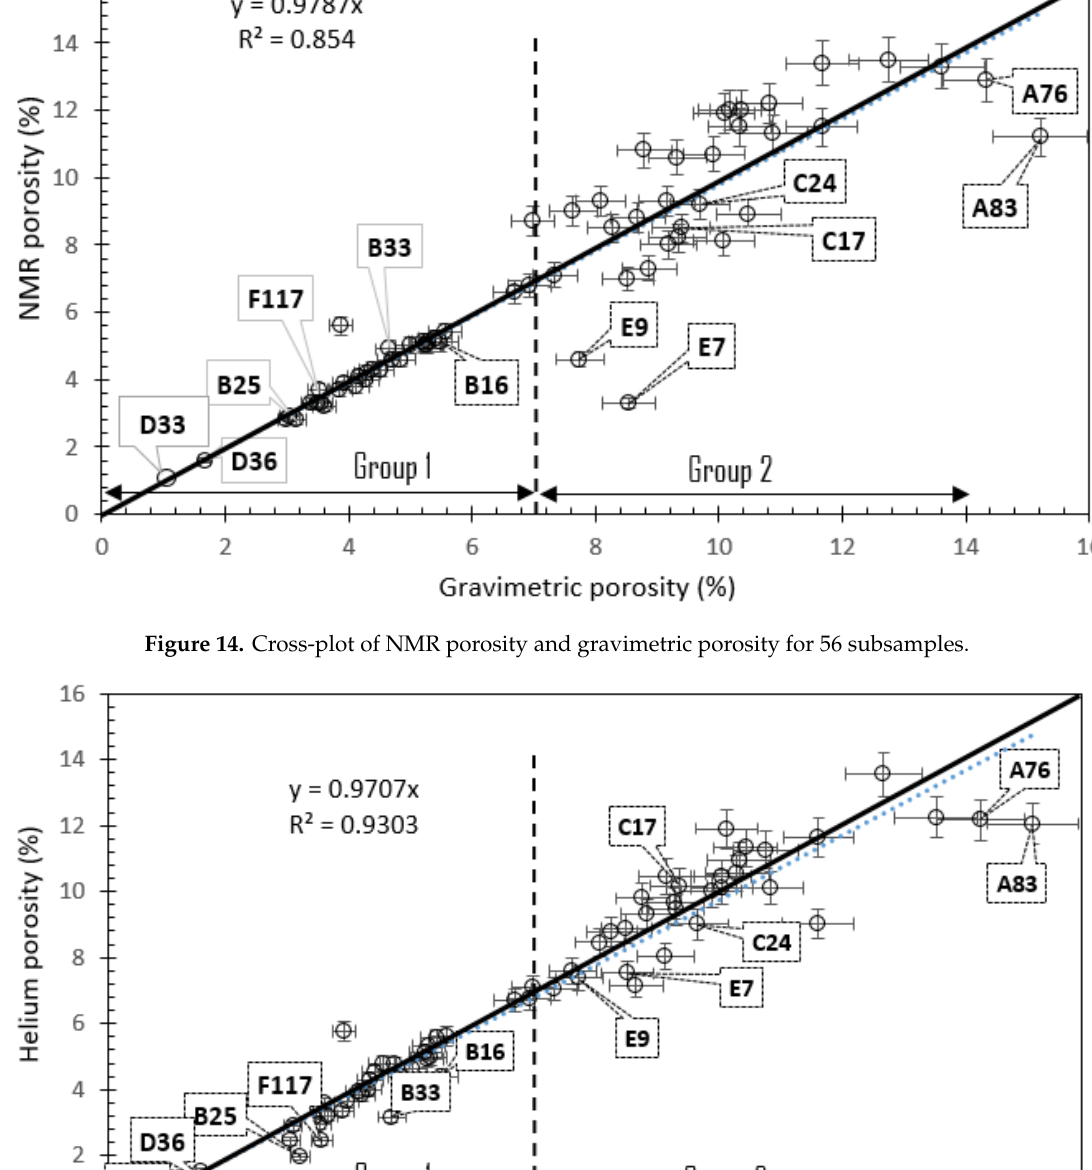
Figure 16. NMR-derived permeability versus core-measured permeability using 𝑇 2𝐿𝑀 .